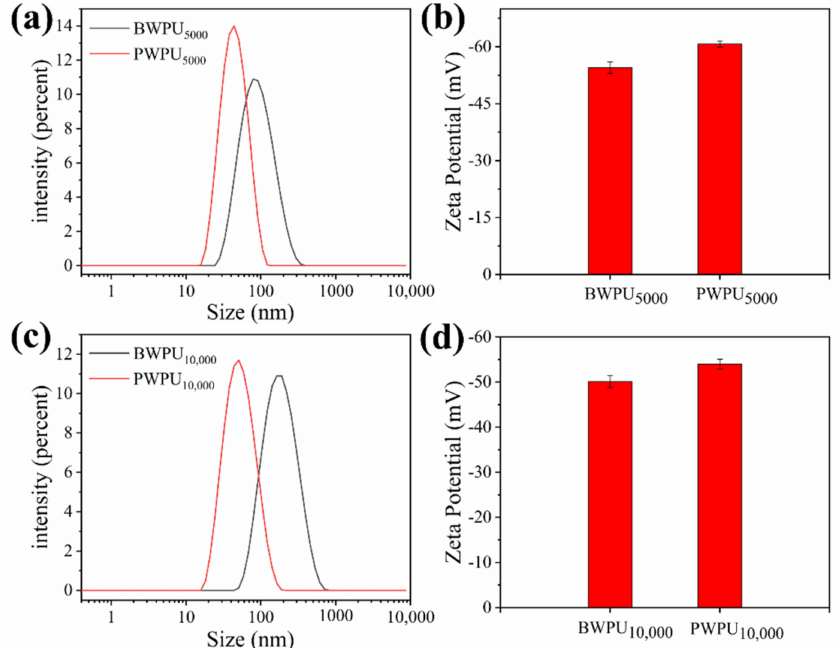
Figure 2. ( a ) Particle size and distribution of BWPU 5000 and PWPU 5000 ; ( b ) zeta potential of BWPU 5000 and PWPU 5000 emulsions; ( c ) Particle size and distribution of BWPU 10,000 and PWPU 10,000 ; ( d ) zeta potential of BWPU 10,000 and PWPU 10,000 emulsions.